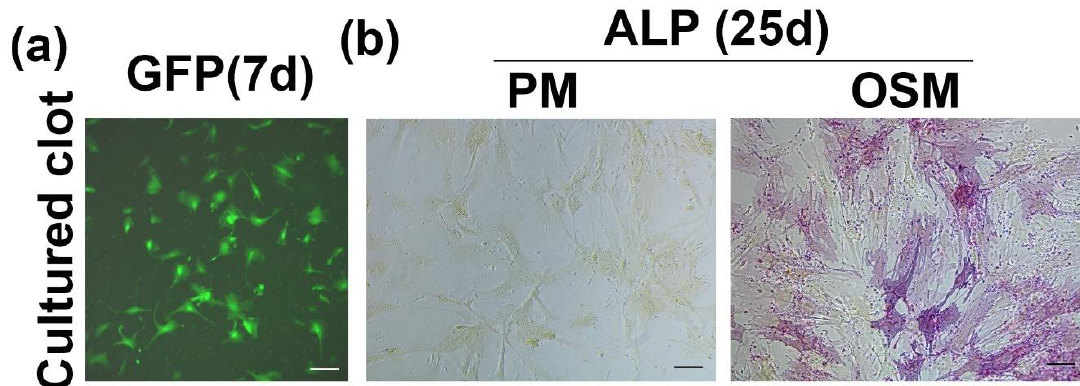
Figure 2. hMDSC can migrate out of the blood clot and undergo proliferation and osteogenic differentiation. ( a ) GFP + hMDSCs migrated out from blood clot. Scale bar = 100 µm. ( b ) ALP staining of cells that migrated out from the blood clot cultured in proliferation medium (PM) and osteogenic medium for 25 days. Cells cultured in osteogenic medium express ALP, while cells cultured in PM (non-osteogenic) remain ALP-negative. Scale bar = 100 µm.